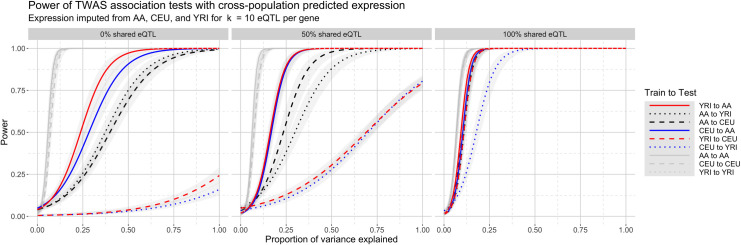
Curves depicting power to detect association under various TWAS scenarios.The x-axis represents the proportion of phenotypic variance explained by gene expression. As in Fig 4, AA reflects simulated African-Americans constructed from YRI and CEU. The curves represent logistic interpolations of whether or not the causal gene was declared significant in an association test of a phenotype from the testing population with gene expression predicted from a training population into the testing population. Gray areas denote 95% confidence regions of mean power conditional on the effect size.